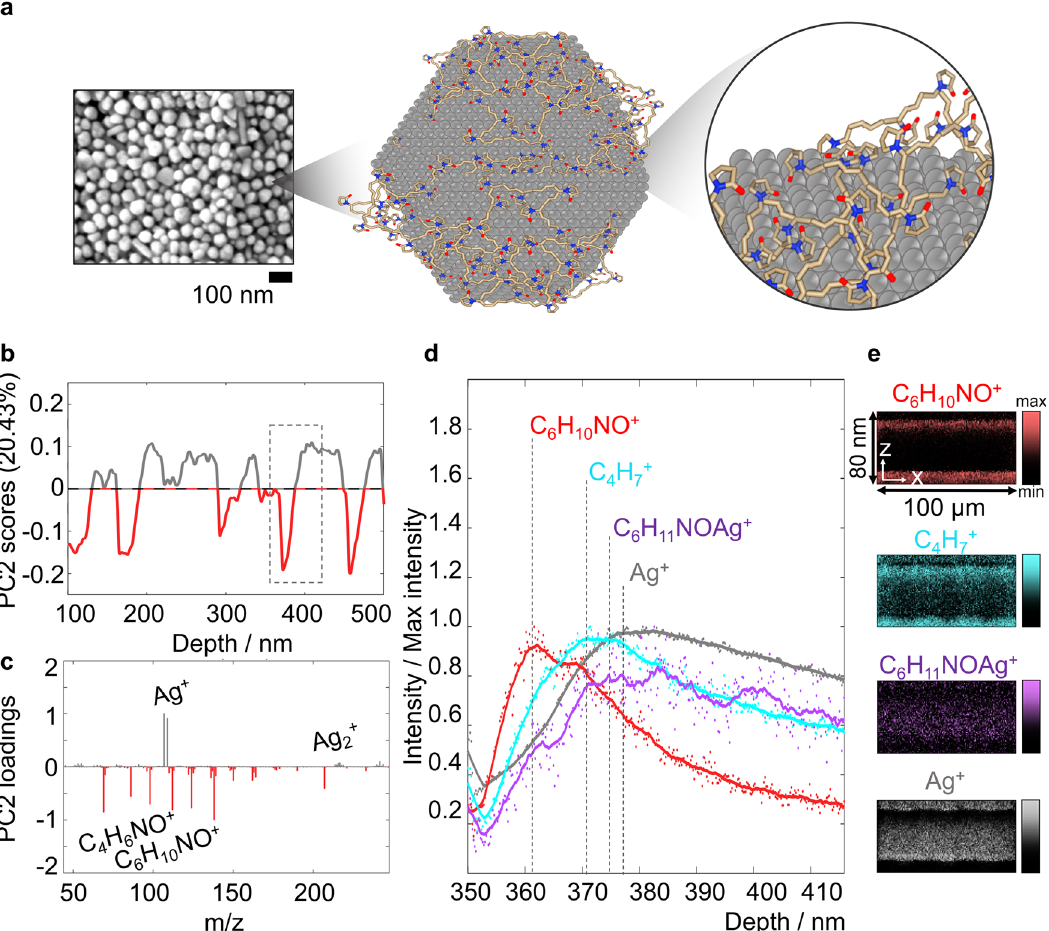
Fig. 3 PVP coordination onto AgNPs surface. a SEM micrograph of printed AgNPs and schematic showing PVP coordination on a single AgNP surface. b PCA scores and c loadings of depth pro fi ling data at nanoparticle depth resolution. The dashed rectangle represents d depth pro fi le within 100 nm showing signals for secondary ions C 6 H 10 NO + , C 4 H 7 + , C 6 H 11 NOAg + and Ag + . e XZ maps within a depth of 80 nm. The data are averaged over an area of 100 × 100 µ m 2 per depth